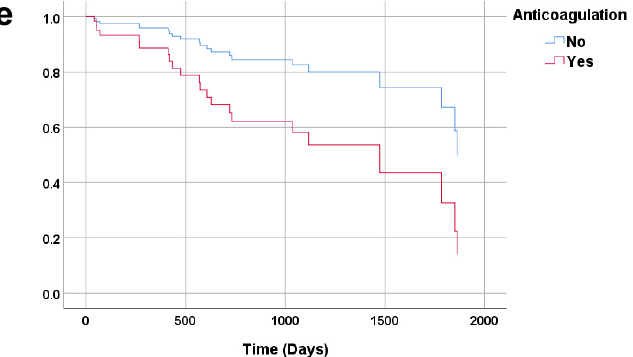
Figure 1. Kaplan–Meier curve analyses for the cumulative incidence of each outcome. ( a ) All-cause mortality ( p = 0.026). ( b ) Cardiovascular mortality ( p = 0.313). ( c ) Major cardiovascular adverse events ( p = 0.166). ( d ) Severe bleeding ( p = 0.021). ( e ) Any bleeding ( p = 0.047). Table 2. Comparison of any anticoagulation and no anticoagulation.